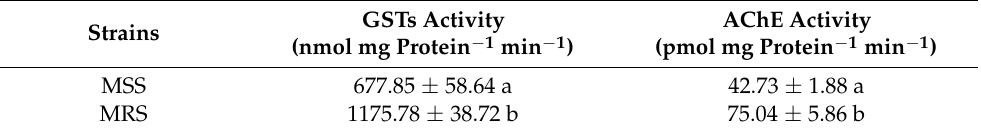
Table 5. Glutathione S -transferase and acetylcholinesterase activities of the MRS and MSS strain 1